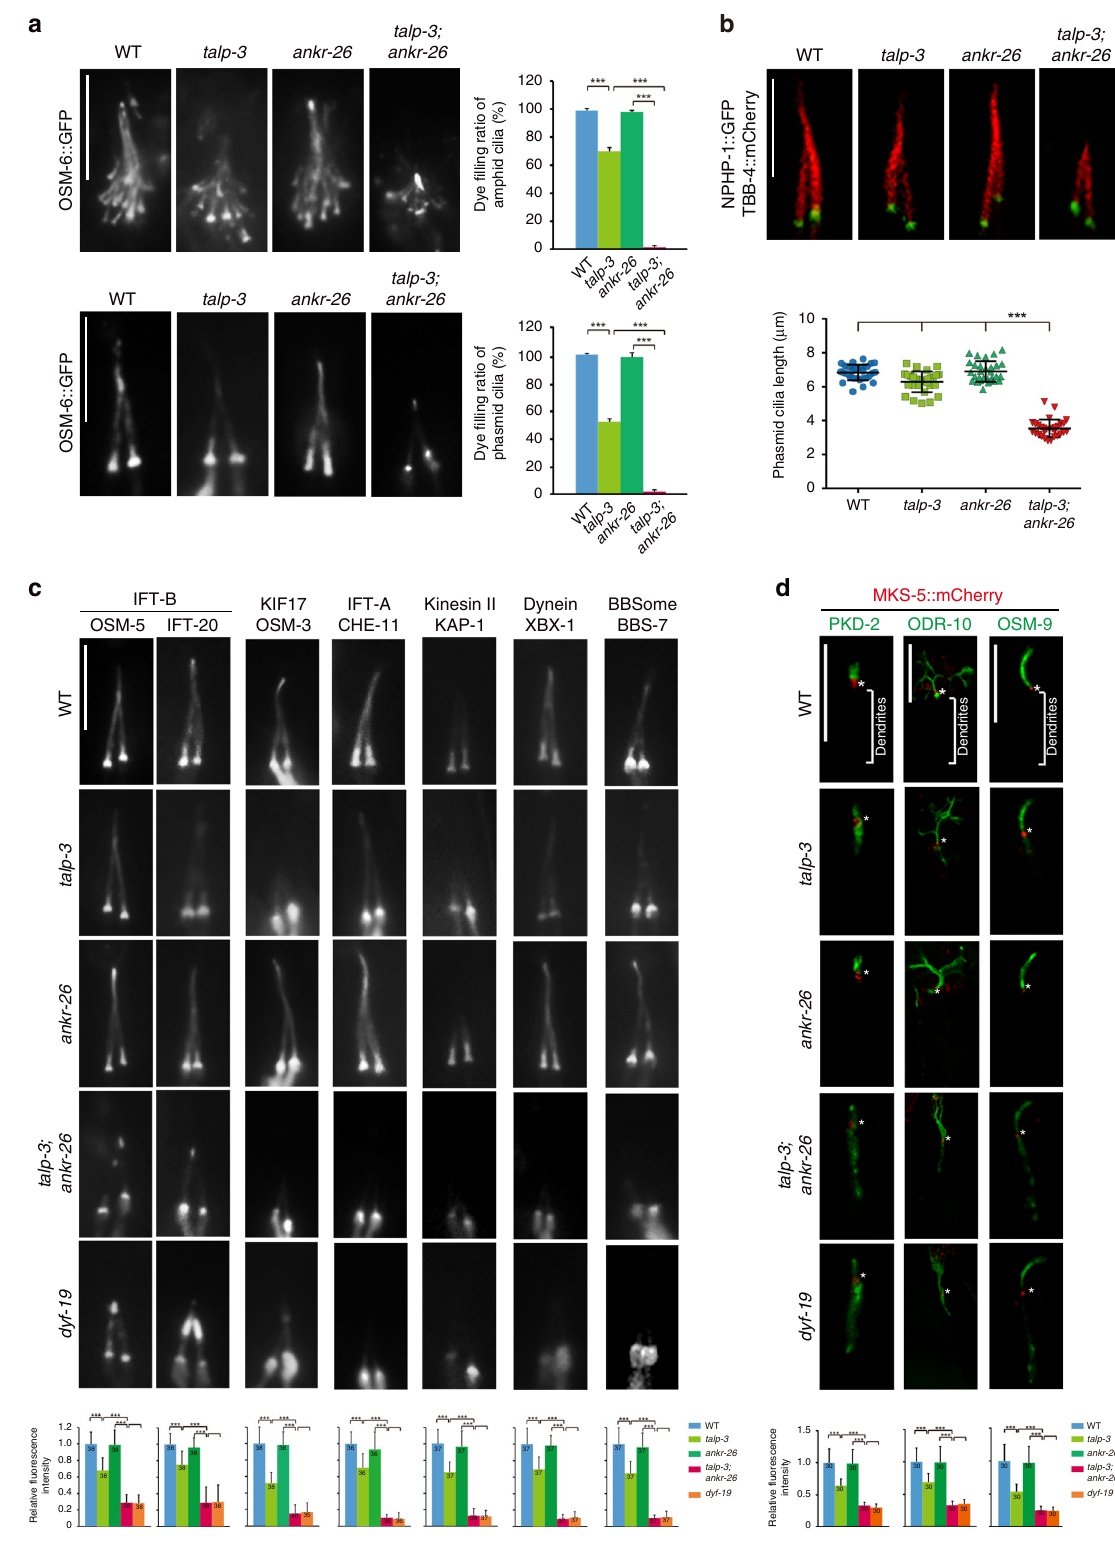
(Fig. 5a, b). To accurately de fi ne their localization on the cen- triole, we performed super-resolution structured illumination (SIM) microscopy. By co-labeling with the subdistal marker ODF2, we con fi rmed that TALPID3 and ANKRD26 localize above subdistal appendages and on the same focal plane as TFs (Fig. 5c). TALPID3 localizes to the distal end of both mother